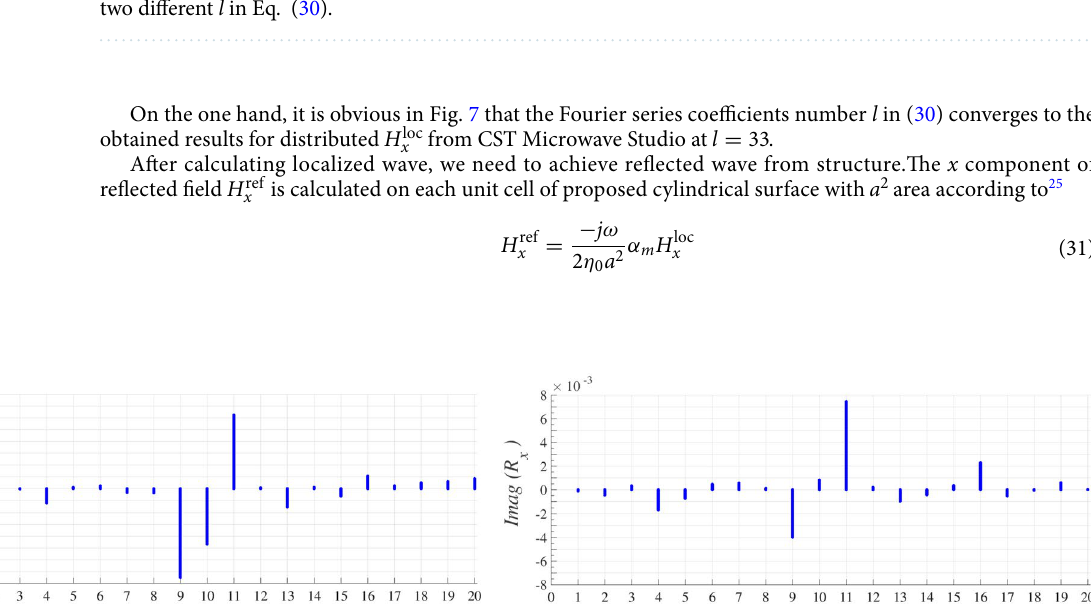
Figure 7. Real parts of distributed H loc x at 10 discreted ϕ angle which is compared to evaluated Fourier series for two different l in Eq. (30).